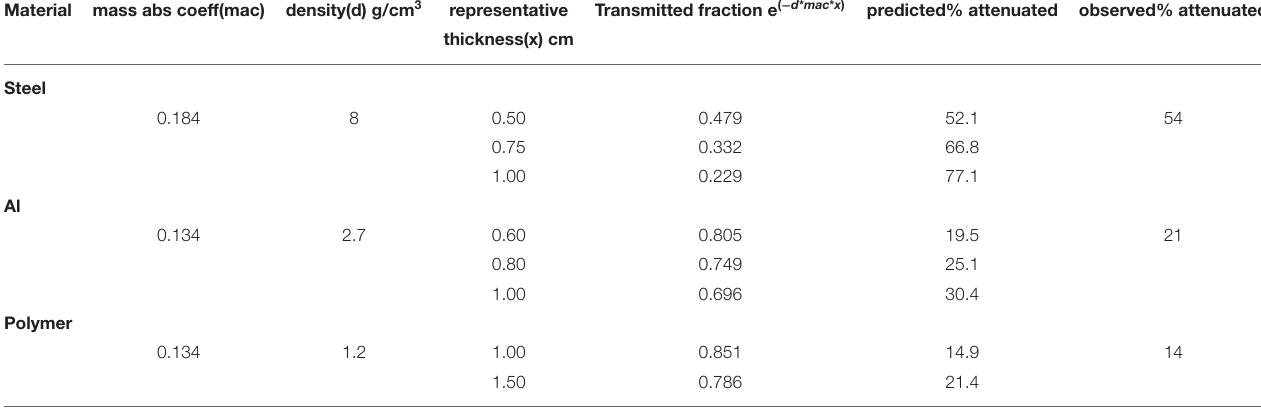
TABLE 6 | Prediction of Attenuation for Different Materials and Thicknesses at 150